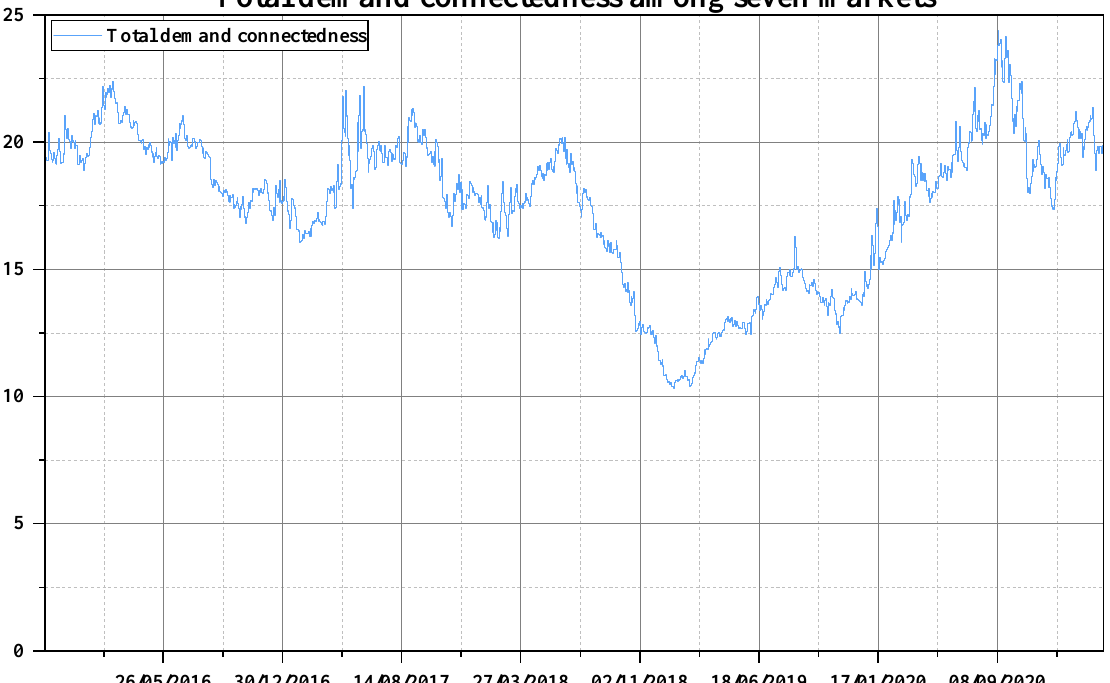
Figure 2. The dynamics of total demand